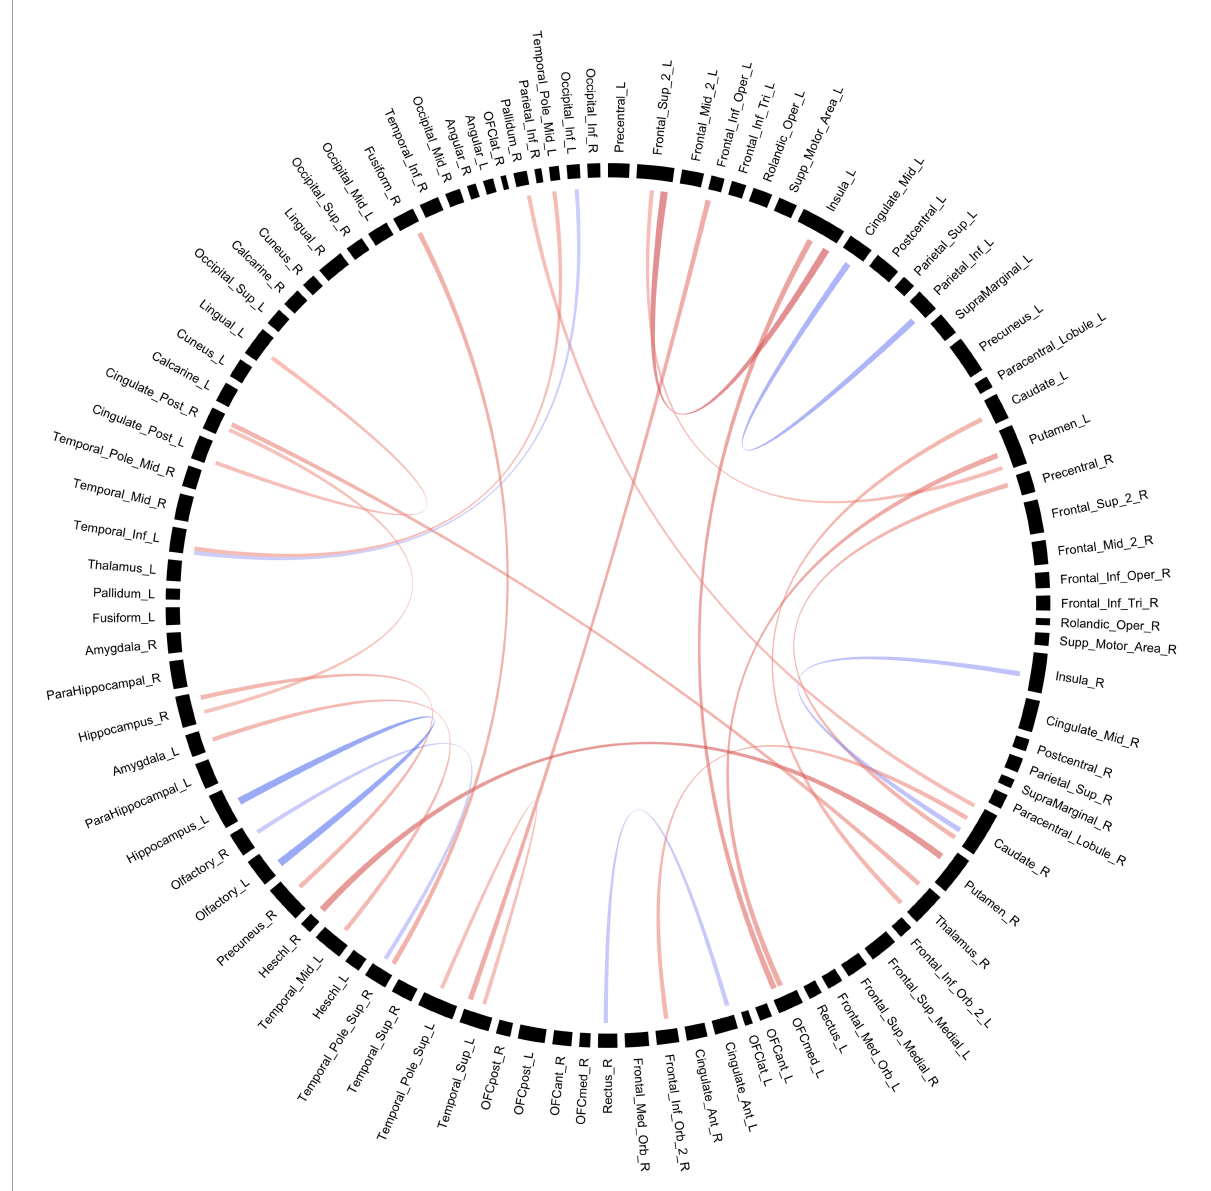
FIGURE3 Structural connectivity between regions of interest based on FA values. Red bands indicate a greater connectivity in the POE group while blue bands indicate greater connectivity in the control group. Band thickness is determined by the t-stat